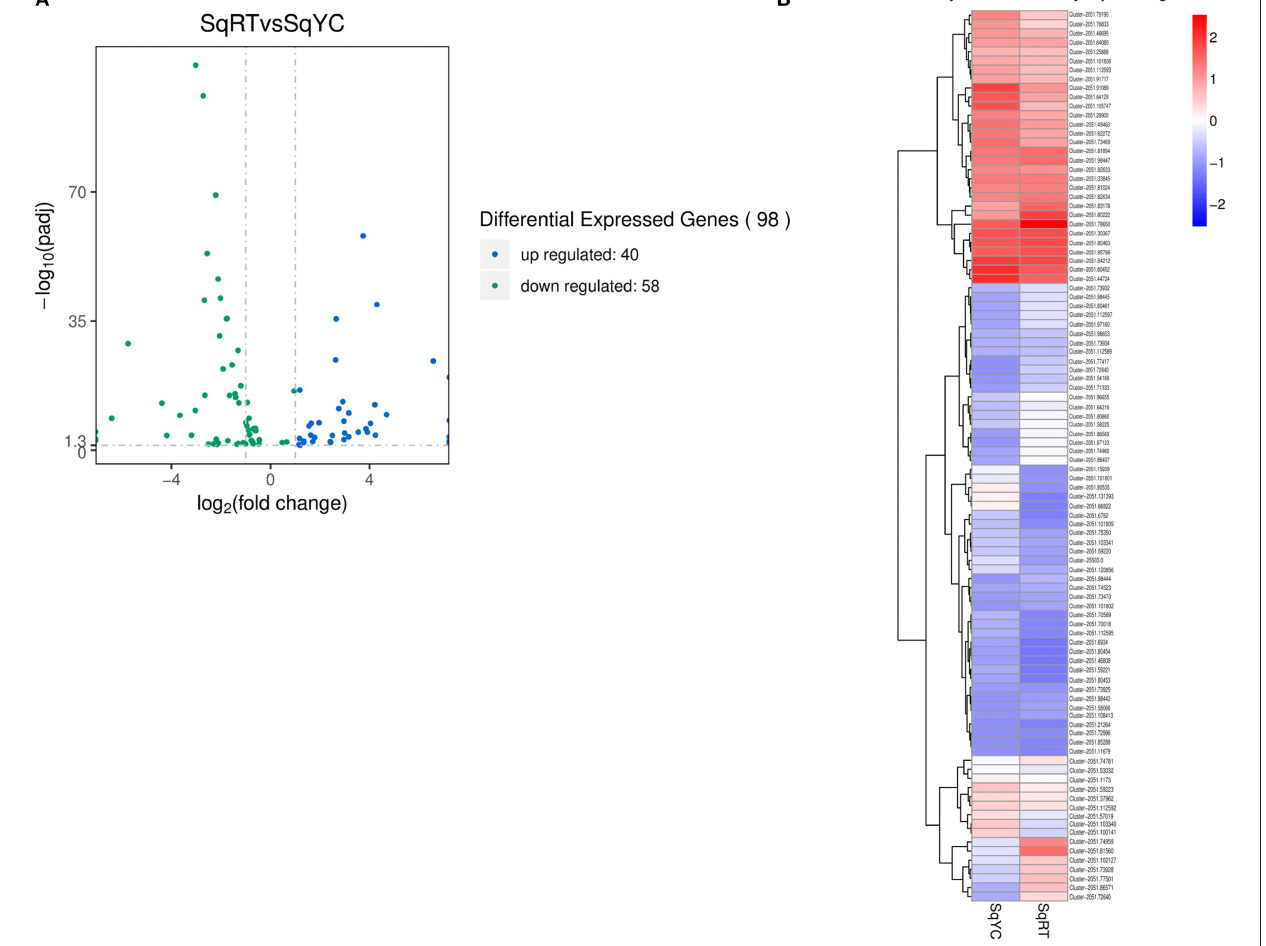
FIGURE 2 | Betalain-related pathways differentially expressed gene (DEG) analysis. (A) Volcano plot of DEG in betalain biosynthesis and aromatic amino acid pathways. (B) Cluster analysis of the 98